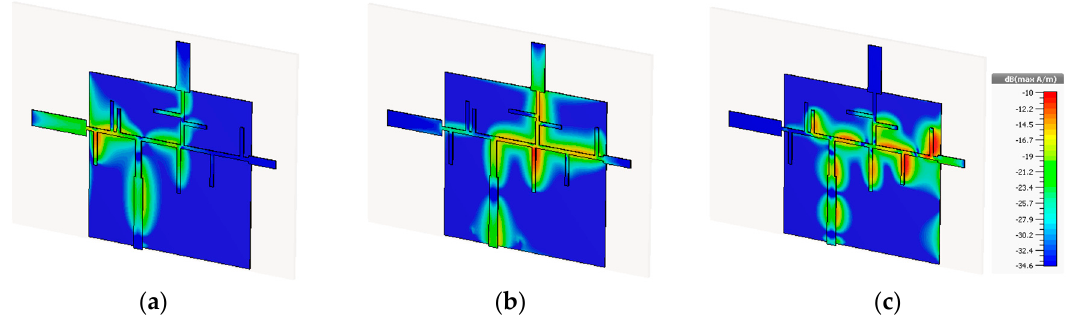
Figure 11. Surface Current Distribution at ( a ) 28 GHz and ( b ) 38 GHz.